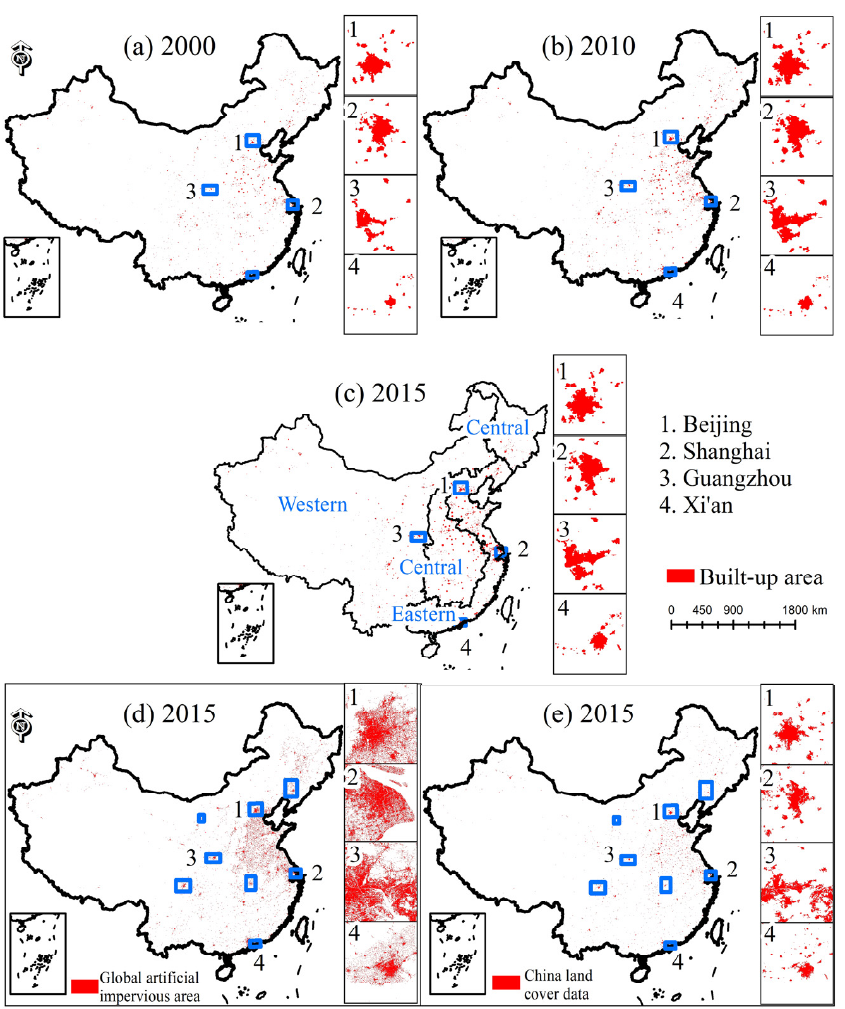
Figure 4. The LS_BUA data, global artificial impervious area (GAIA), and China land cover data (CLUD) in China.